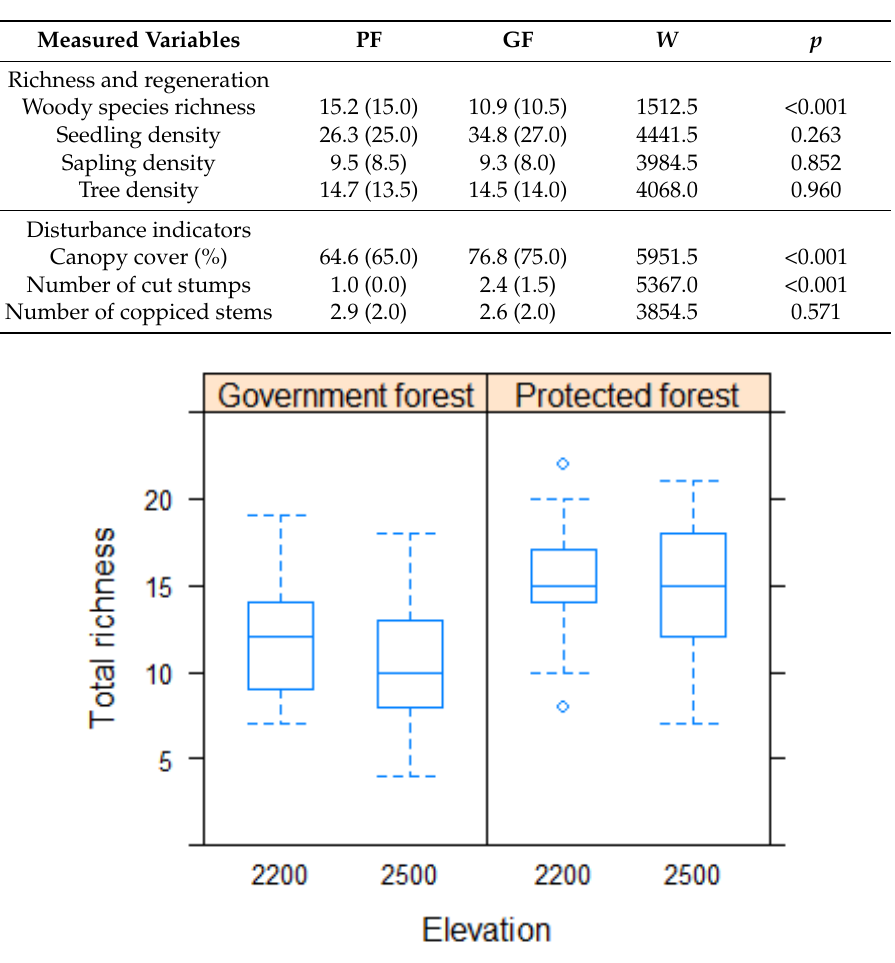
Figure 2. Box–Whisker plots with median (thick line), 25% and 75%-quantiles (upper/lower box line) and outliers (circles), showing the comparison of total woody species richness between upper and lower elevation (masl) in government forests (GF) and protected forests (PF) in the Langtang area of Nepal ( n = 180).